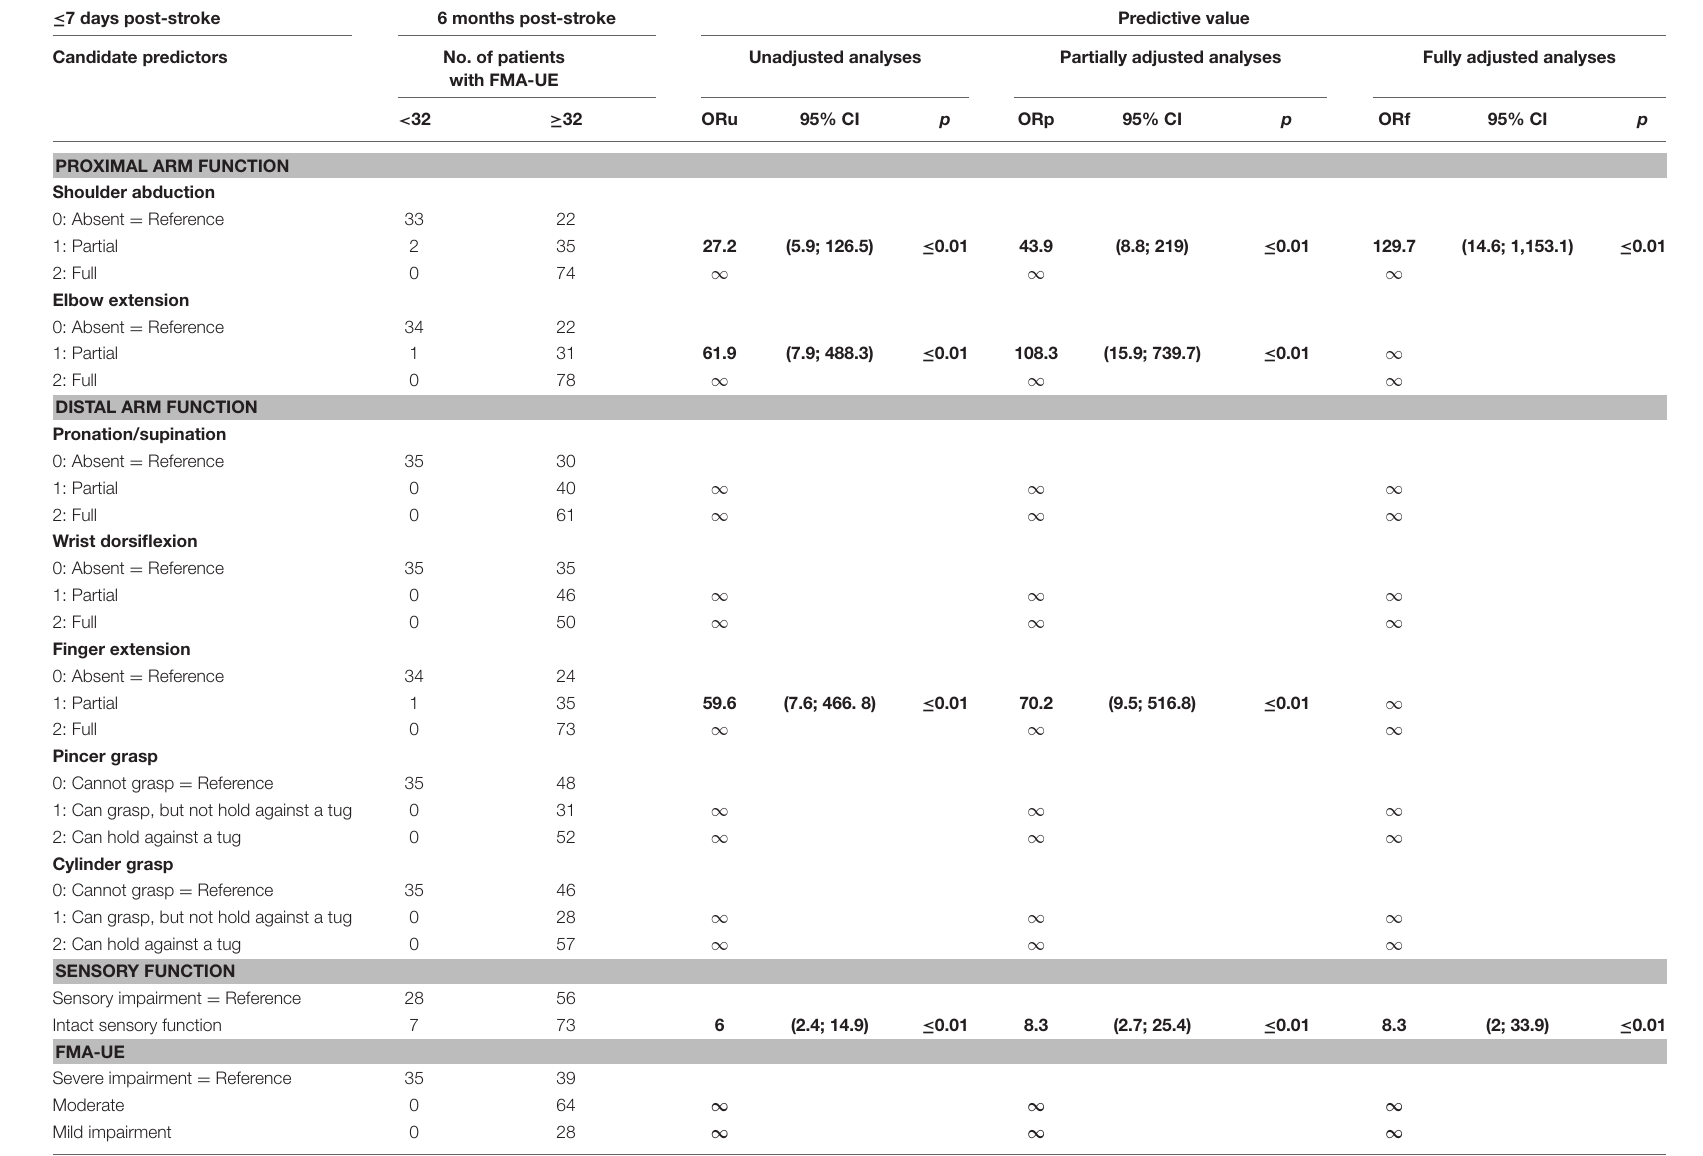
TABLE 2 | Odds ratio of FMA-UE ≥ 32 at 6 months post-stroke for each candidate predictor. ≤ 7 days post-stroke 6 months post-stroke Predictive value Candidate predictors No. of patients Unadjusted with FMA-UE